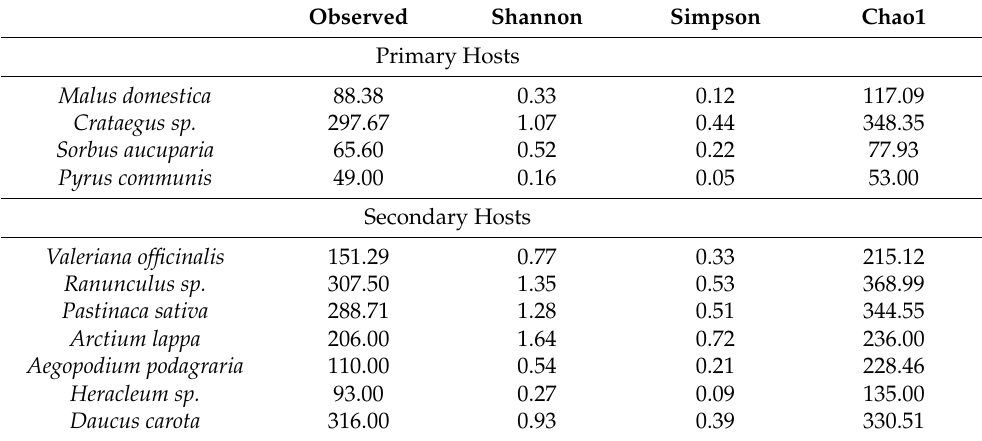
Table 3. Values of alpha diversity indicators of symbionts in reference to host plant species.